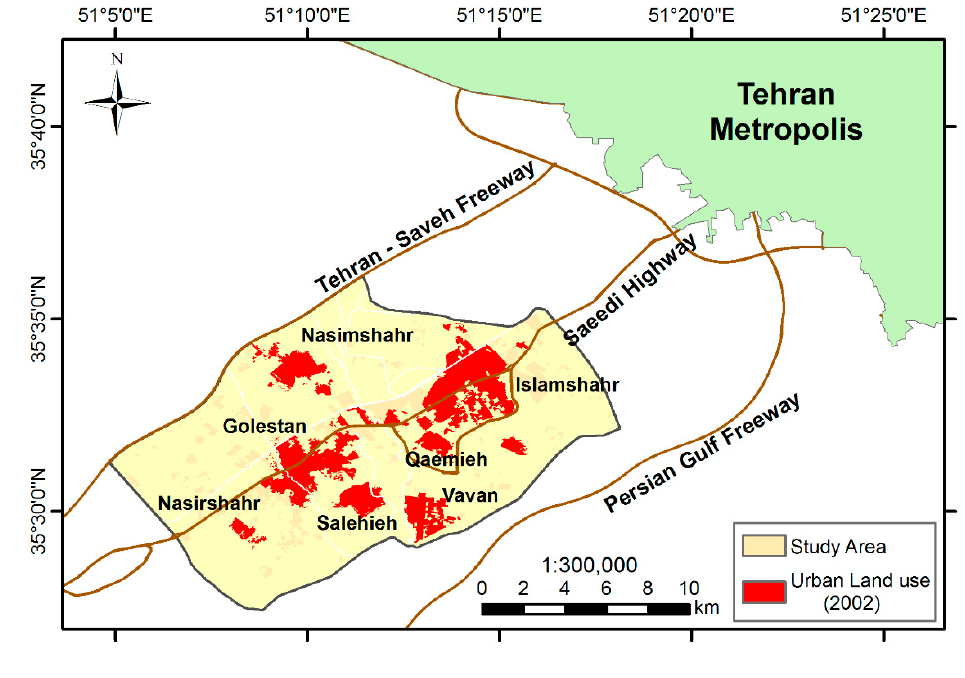
Figure 1. Study area.